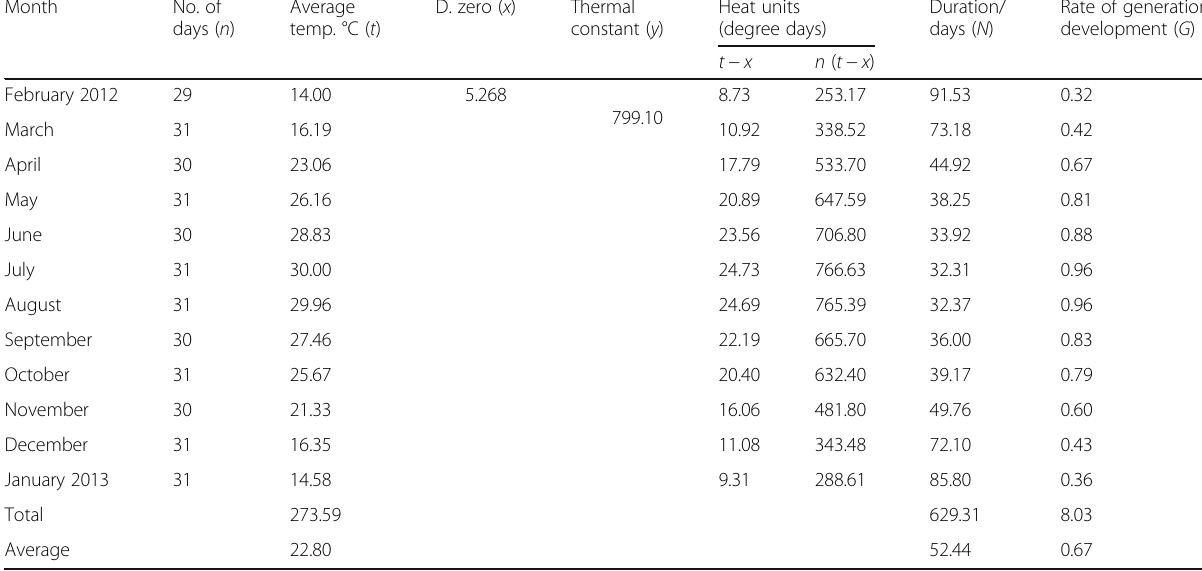
Table 2 Calculated heat units required for the life cycle of females of Tuta absoluta in Giza governorate from February 2012